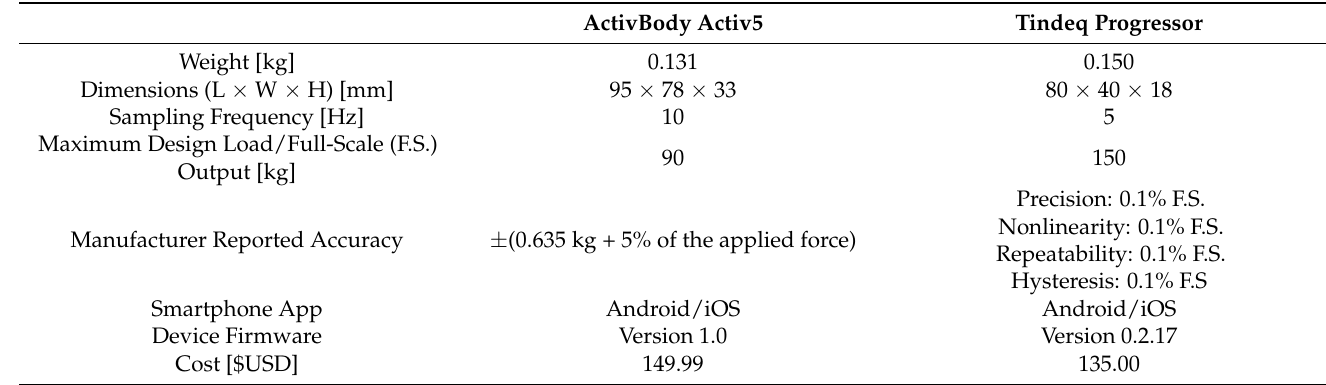
Table 1. Specification of consumer-grade load